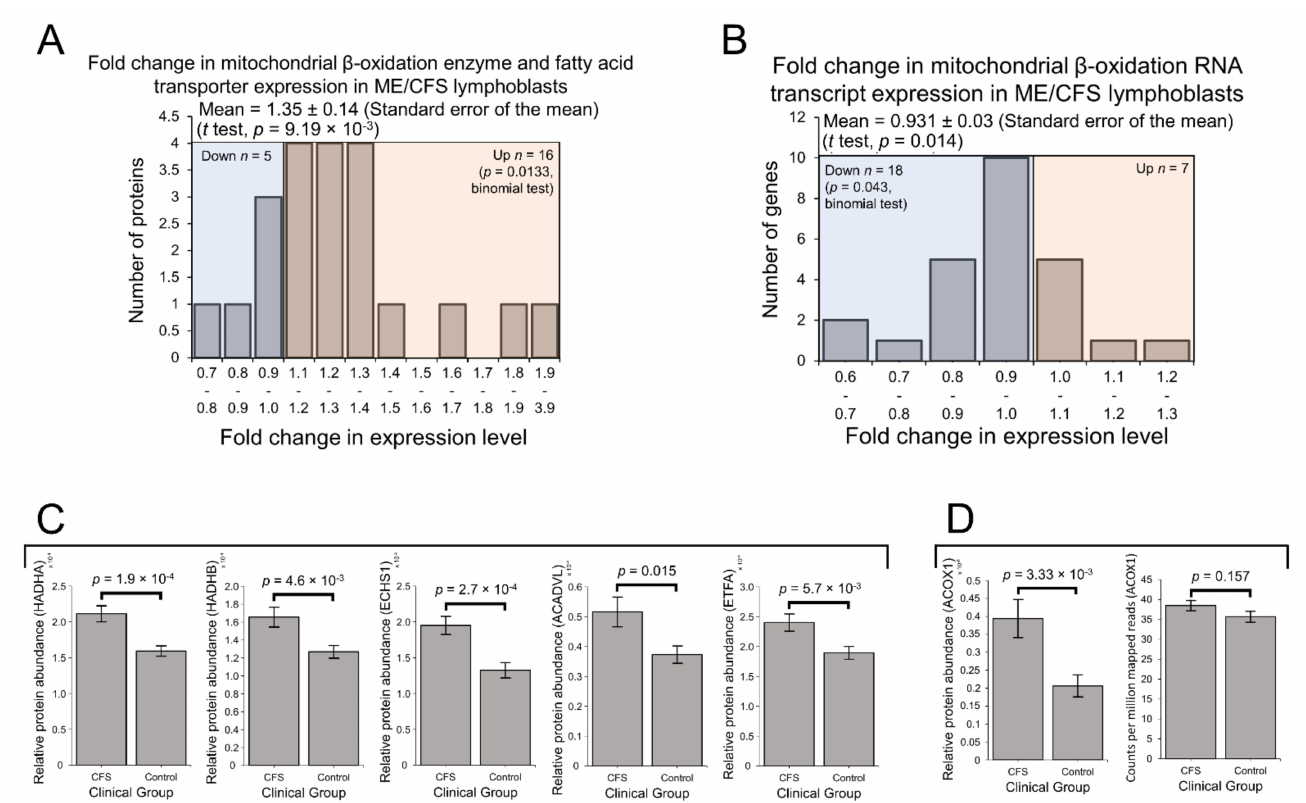
Figure 5. Expression of proteins involved in mitochondrial and peroxisomal fatty acid β -oxidation was elevated in Myalgic Encephalomyelitis/Chronic Fatigue Syndrome (ME/CFS) lymphoblasts. Error bars represent the standard error of the mean. RNA sequencing transcriptomics experiment: ME/CFS n = 23, control n = 17. Each cell line was sampled once. Mass spectrometry proteomics experiment: ME/CFS n = 34, control n = 31. Each cell line was sampled once, or twice for a subset of healthy controls arbitrarily selected to act an internal control between experiments in the proteomics work. ( A ) A total of 21 proteins involved in mitochondrial fatty acid β -oxidation and transport were detected within the whole-cell proteomes of ME/CFS and control lymphoblasts. Fold change refers to the mean abundance of a given protein in the CFS group divided by the mean abundance in the control group. The proportion of detected proteins that were upregulated (binomial test with H o set to 0.5 and H 1 being that the upregulated proportion was greater) and the average extent of the upregulation (single-sample t test with H o ≤ m1 and H 1 m>1) were statistically significant. ( B ) A total of 25 RNA transcripts encoding proteins involved in mitochondrial fatty acid β -oxidation and transport were detected by RNA sequencing within the whole-cell transcriptomes of ME/CFS and control lymphoblasts. Fold change refers to the mean abundance of a given transcript in the CFS group divided by the mean abundance in the control group. The proportions of reduced or elevated transcripts were not significantly different (binomial test with H o p = 0.5) nor was the average magnitude of expression (single-sample t test with H o m = 1). ( C ) The expression levels of both subunits of the mitochondrial trifunctional enzyme complex Hydroxyacyl-CoA dehydrogenase/3-keotacyl-CoA thiolase (HADHA and HADHB), very long-chain specific acyl-CoA dehydrogenase (ACADVL), enoyl-CoA hydratase (ECHS1) and electron transfer flavoprotein subunit alpha (ETFA (are significantly elevated in whole-cell mass spectrometry proteomics experiments (independent t test ). Relative abundance was obtained from Intensity-Based Absolute Quantitation values normalised to the control average within the respective individual experiments. ( D ) The expression of Acyl-CoA oxidase 1 (ACOX1) was significantly elevated in whole-cell mass spectrometry proteomics experiments (independent t test ). Relative abundance was obtained from Intensity-Based Absolute Quantitation values normalised to the control average within the respective individual experiments. ACOX1 expression was not altered at the transcriptional level as measured by whole-cell RNA sequencing transcriptomics. Counts per million mapped reads were calculated for each gene